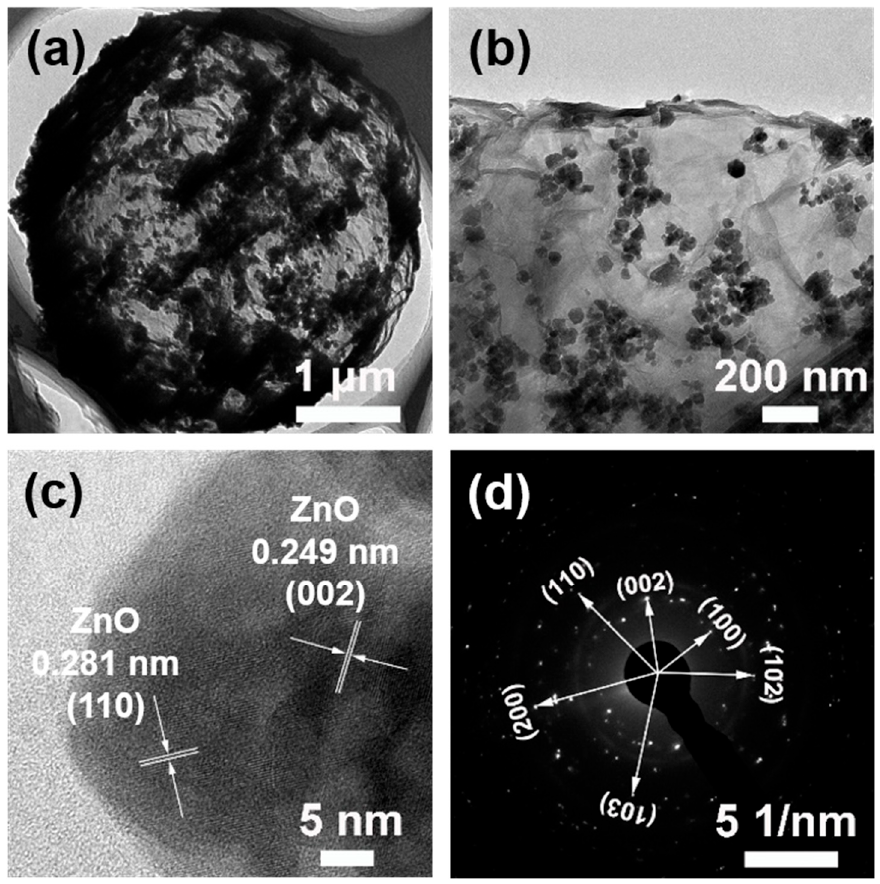
Figure 3. ( a , b ) TEM images of 3D-ZnO/rGO. ( c ) high resolution TEM image of 3D-ZnO/rGO. ( d ) the selected area electron diffraction (SAED) pattern of 3D-ZnO/rGO.